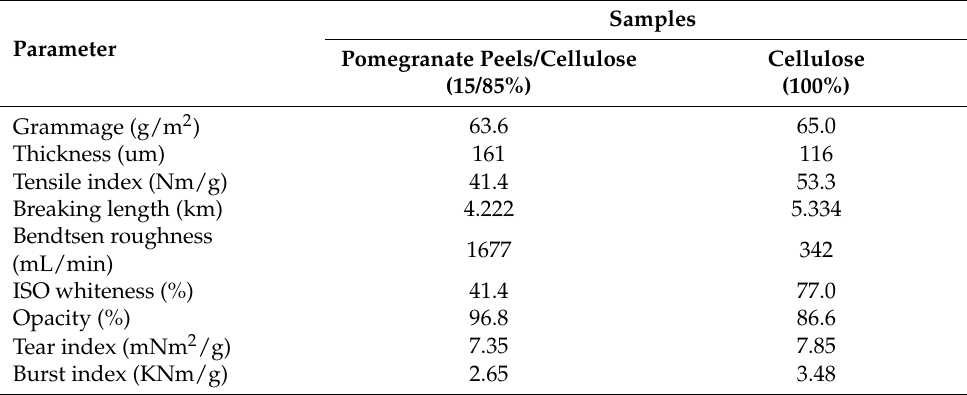
Table 10. Optical and mechanical properties of